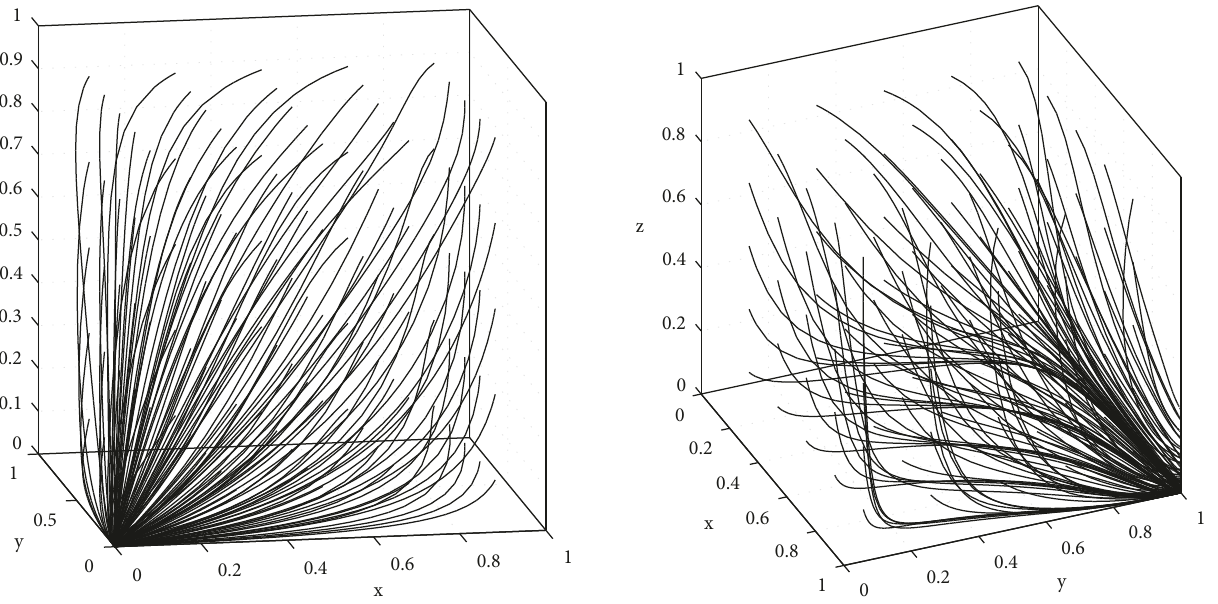
Figure 9: Dynamic evolution path of case 8.